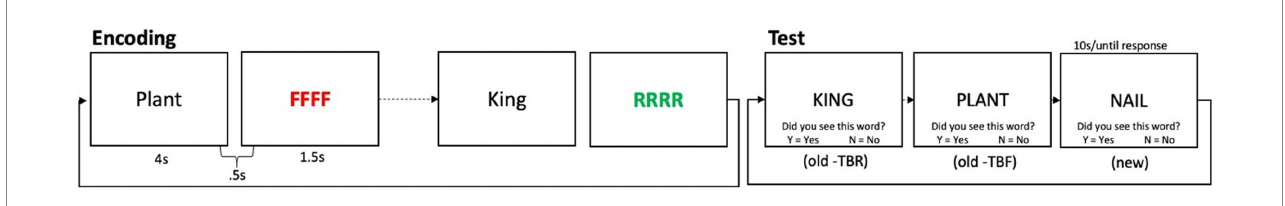
FIGURE 1 Schematic of the directed forgetting task. The 4 red Fs cued participants to forget the preceding word (e.g., Plant), whereas the 4 green Rs cued participants to remember the preceding word (e.g., “King”). Recognition memory for to-be-remembered (“TBR”), to-be-forgotten (“TBF”), and new (unpresented) words was then